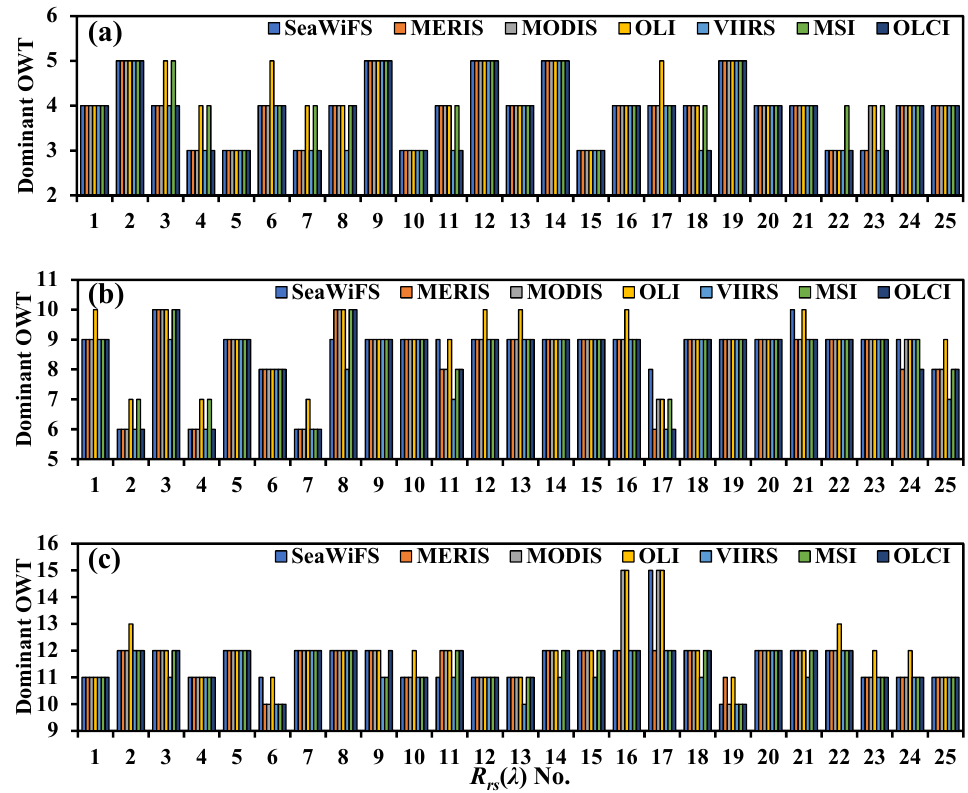
Figure 5. The U-OWT dominant OWT of the IOCCG synthetic R rs ( λ ) for different water trophic states: ( a ) 25 R rs ( λ ) spectra with Chla = 0.3 μ g/L (oligotrophic), ( b ) 25 R rs ( λ ) spectra with Chla = 3 μ g/L (mesotrophic), ( c ) 25 R rs ( λ ) spectra with Chla = 30 μ g/L (eutrophic).